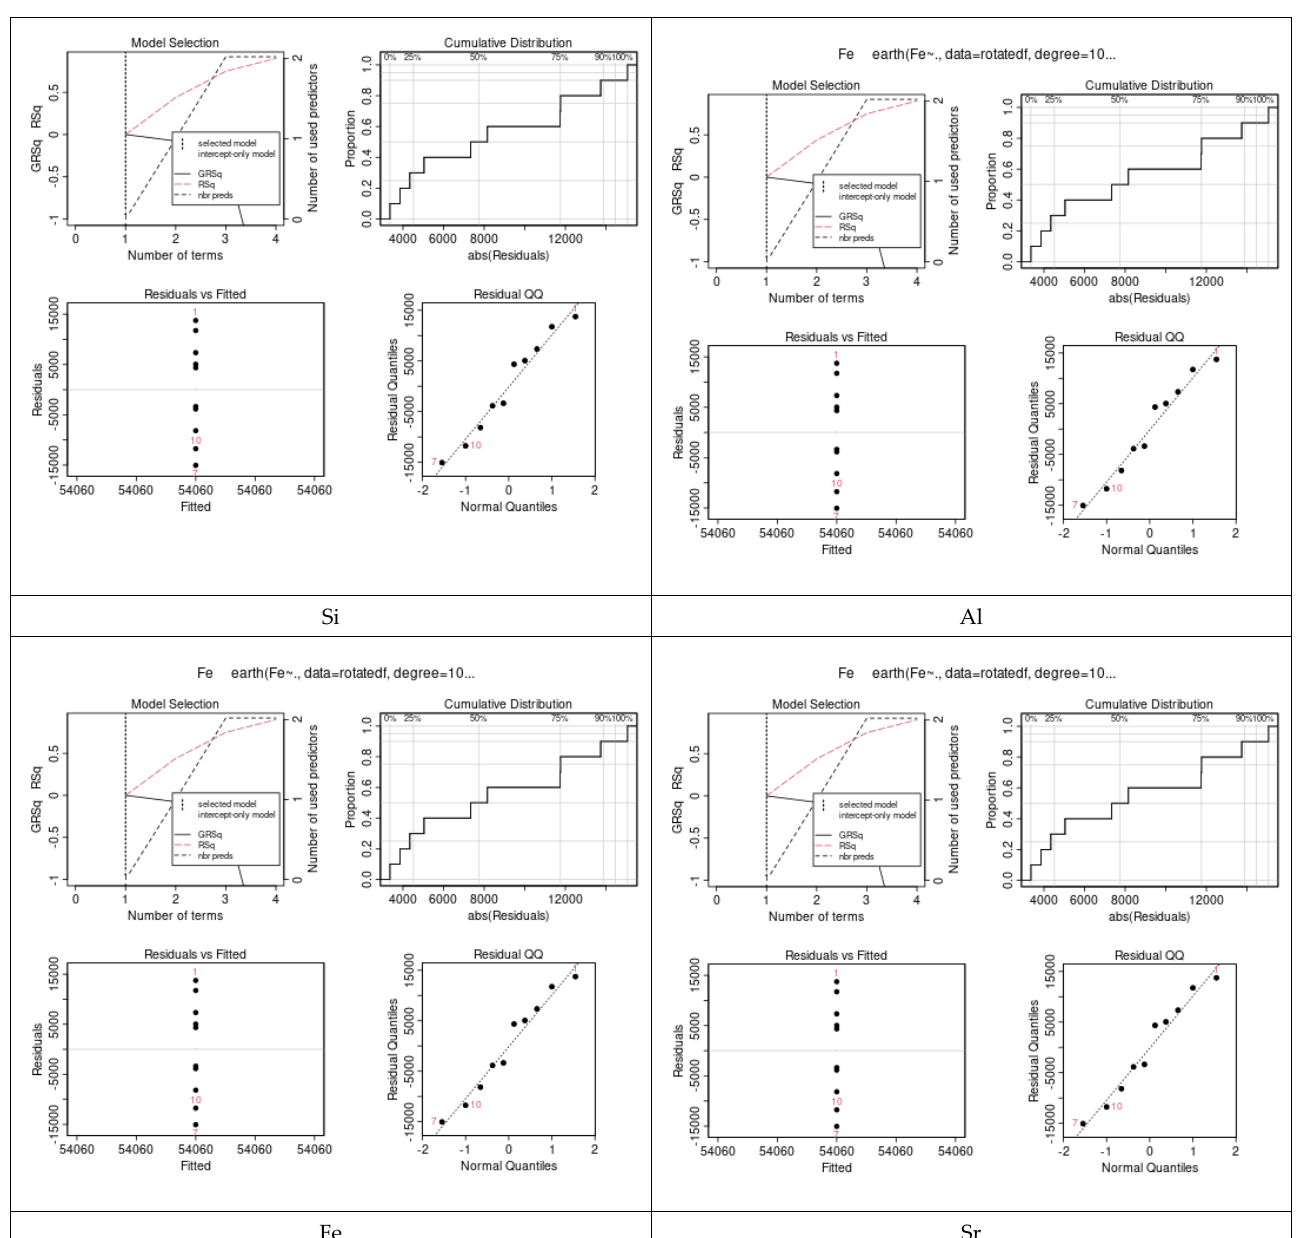
Figure 10. Prediction error of the MARS models for a sample of some selected elements. Four prediction performances included: the cumulative distribution of prediction errors, residual vs. fitted, residual QQ and GRSq. The values of the performance metrics vary among the elements.